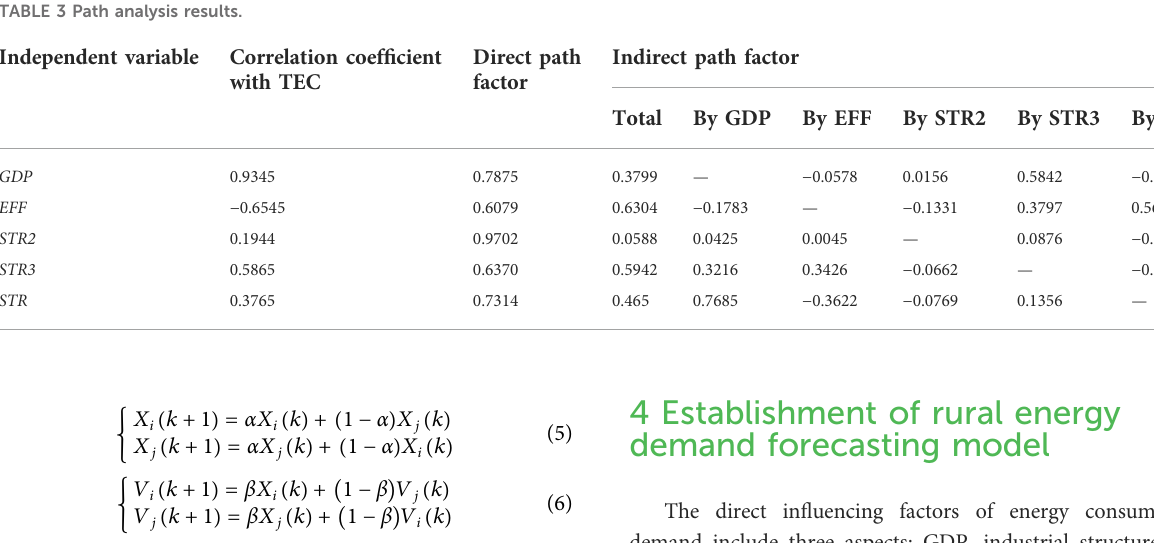
TABLE 3 Path analysis